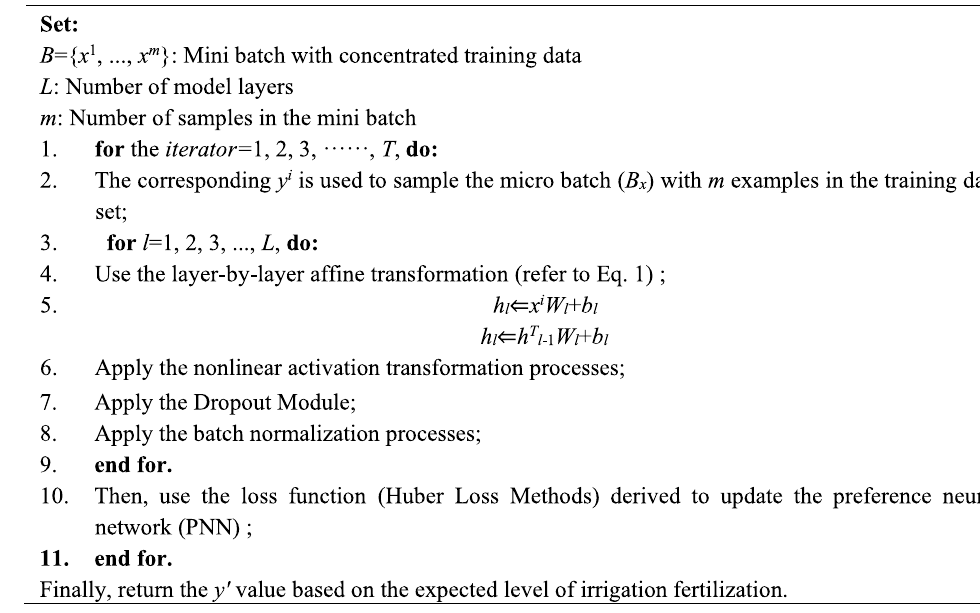
Table 4. Algorithm of Preference neural